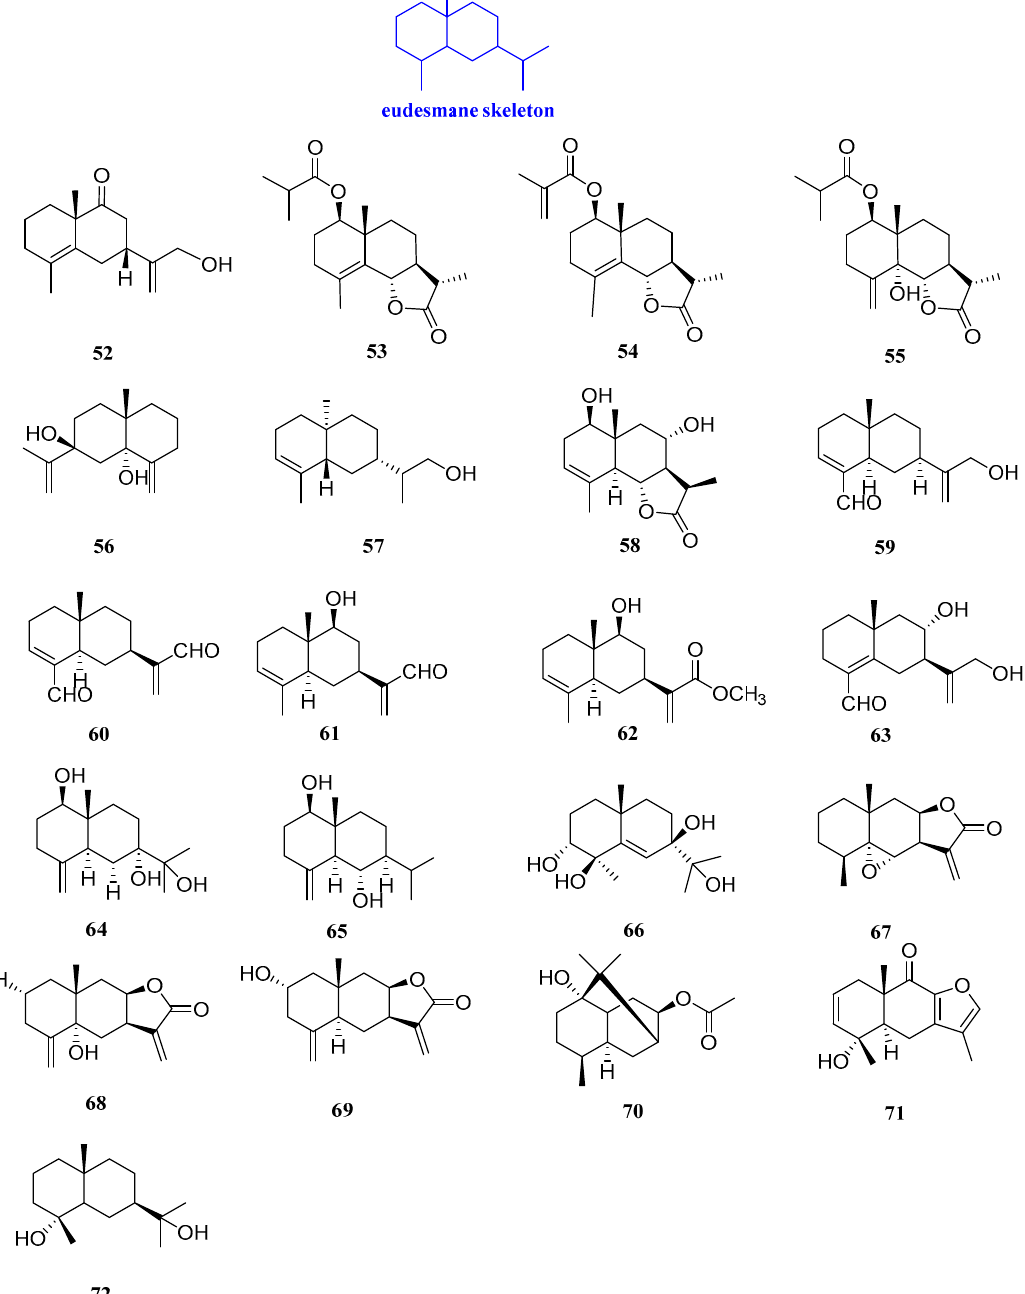
Figure 5. Structures of eudesmane-type sesquiterpenoids 52 – 72 . Artemivestinolides D–F ( 53 – 55 , Figure 5) were isolated from Artemisia vestita , Com- pound 53 had a good inhibitory effect on Pyricularia oryzae , with a MIC value of 128 mg/L. Compounds 53 and 54 against B. cinerea , with the same MIC value of 256 mg/L. For F. oxysporum , compound 55 displayed antifungal activity, with a MIC value of 256 mg/L [23]. Eudesma-4(15),11-diene-5,7-diol ( 56 , Figure 5) was extracted from Laurencia obtusa Lamouroux with antibacterial activity. Compound 56 possessed antifungal activity against C. albicans and Candida tropicalis ( C. tropicalis ), with MIC values of 8.27 and 10.13 µM, respectively. The antifungal activity of compound 56 was higher than amphotericin B (MICs = 4.63 and 5.27 µM, respectively) [36].